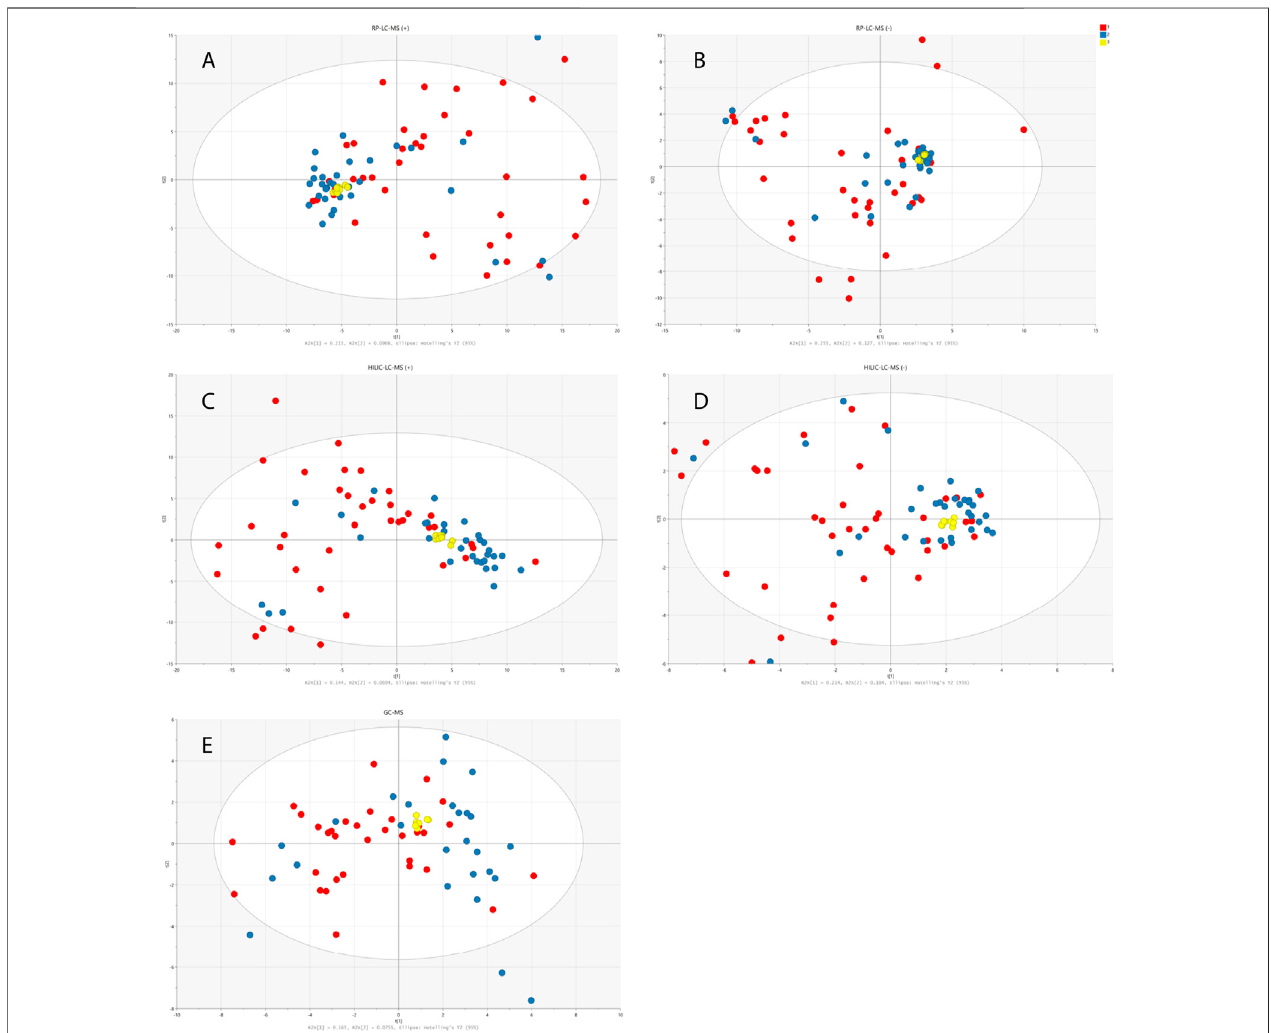
FIGURE 2 | PCA models built on data obtained from RP-LC-TOF-MS analysis in positive (A) and negative (B) ionization modes, HILIC-LC-TOF-MS analysis in positive (C) and negative (D) ionization modes and from GC-MS analysis (E) . Red circles correspond to samples from disease group, blue ones represent healthy controls and yellow ones QC